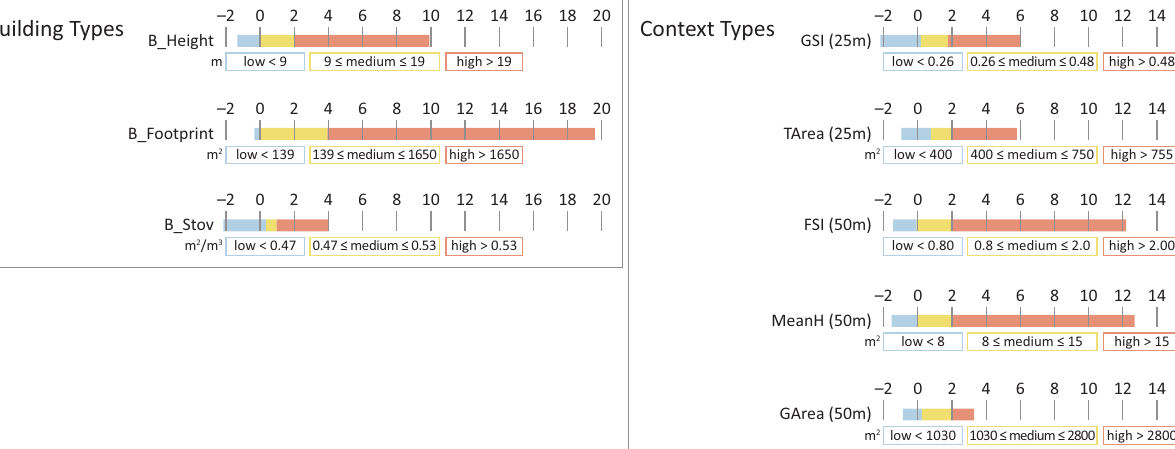
Figure 4. Numerical thresholds for the description of the building types (left) and context types